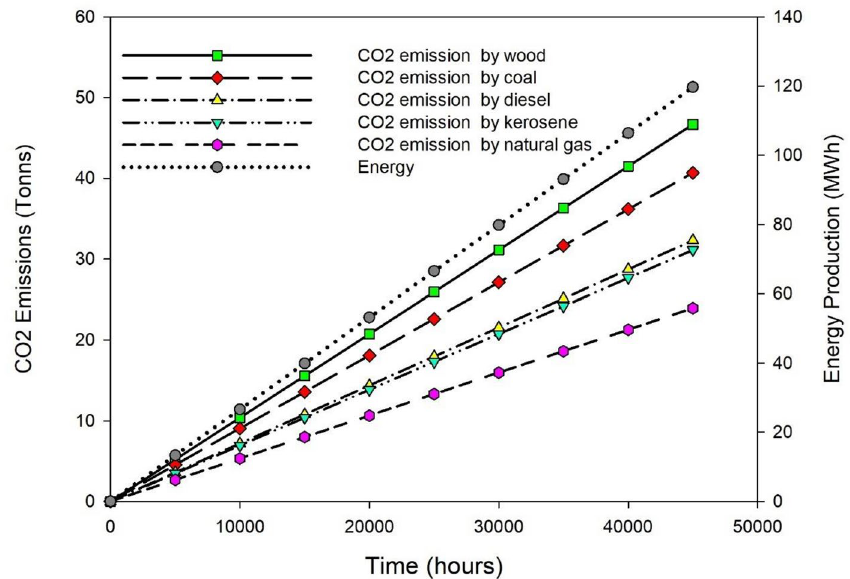
Figure 7. CO 2 emission savings by solar yogurt processing